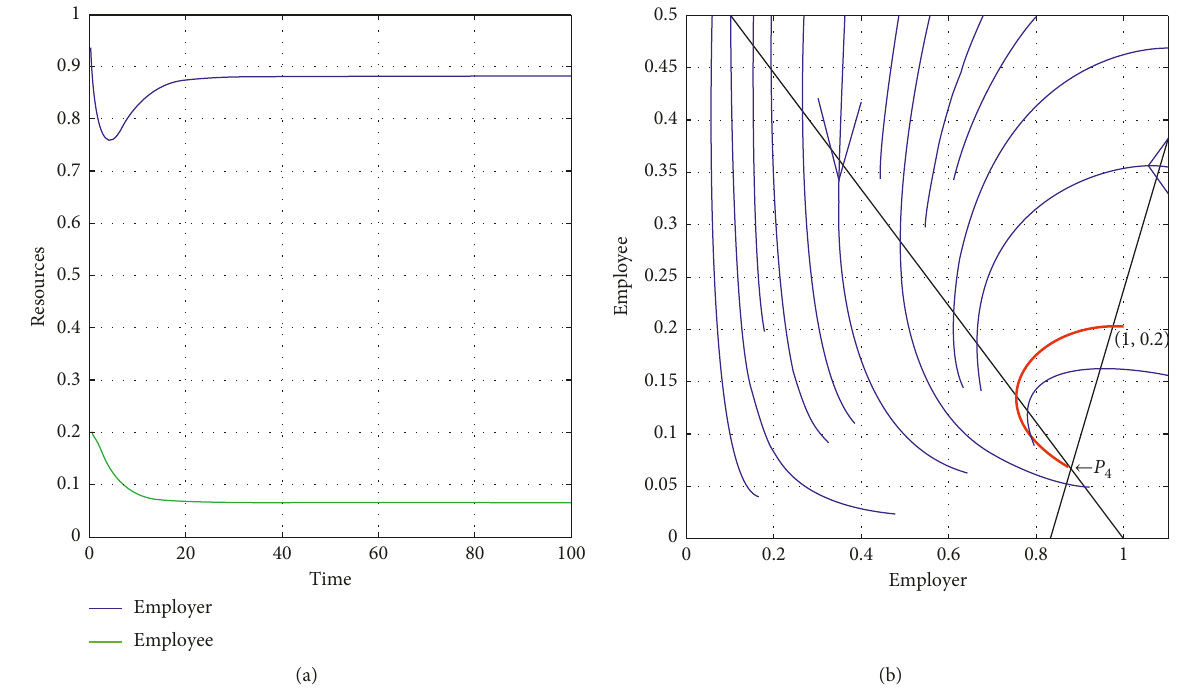
Figure 5: The simulation result and the phase diagram in the lose-lose